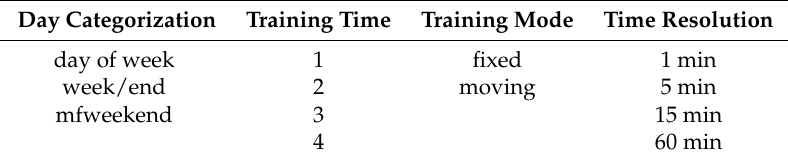
Table 2. Variables used for occupancy model